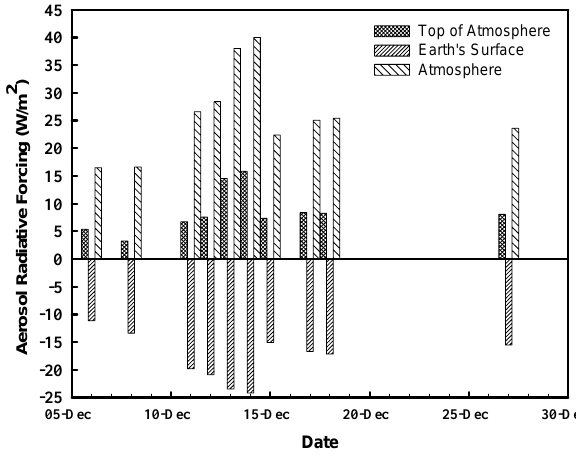
Figure 8 Fig. 8. Daily averaged aerosol radiative forcing over Hissar for those days when aerosol optical depth data are available.